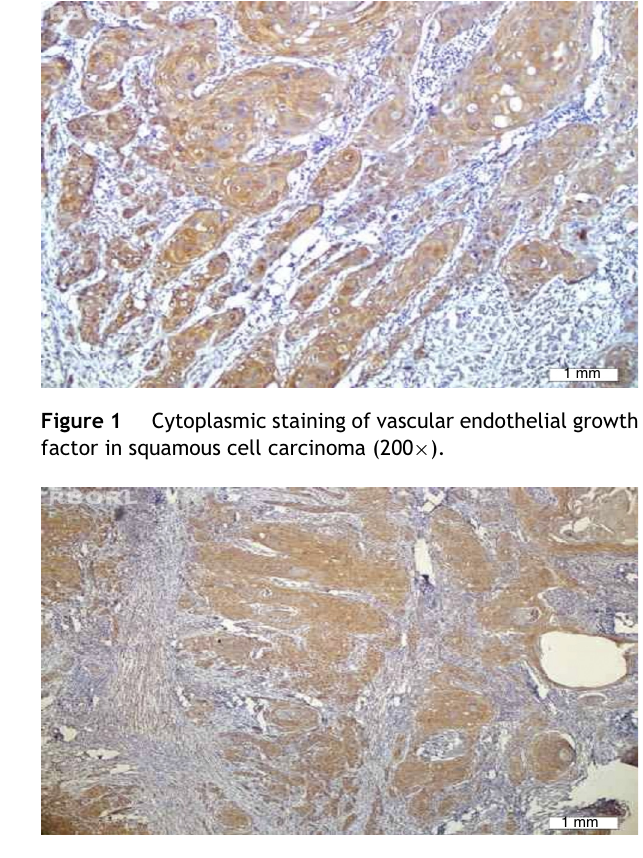
Vascular endothelial growth factor expression was negative around keratin pearls (100 ×